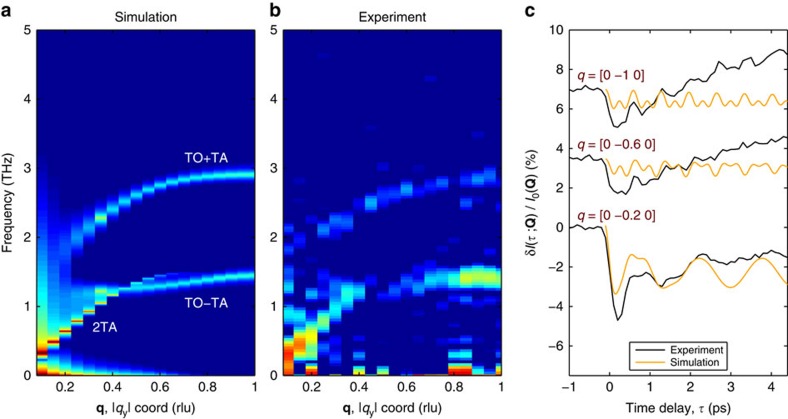
Simulation and experimental results show combination and overtone modes.(a) Simulated FT-IXS spectrum along the Δ line in the (1 3) BZ. The 2TA and TO±TA modes are labelled. The spectrum qualitatively matches the experimental data in b. (b) Experimental FT-IXS spectrum along the same high-symmetry direction in the (1 3) BZ seen in Fig. 2b and with the slowly varying low frequency background filtered. (c) Comparison of experimental time-domain signal (black traces, unfiltered) at select wavevector coordinates along Δ as taken from Fig. 2a with calculated signal (orange traces). There is a good qualitative match between experimental and model results, notably in the strong initial dip seen at τ=0, connected to a considerable hardening of the TO branch frequencies.